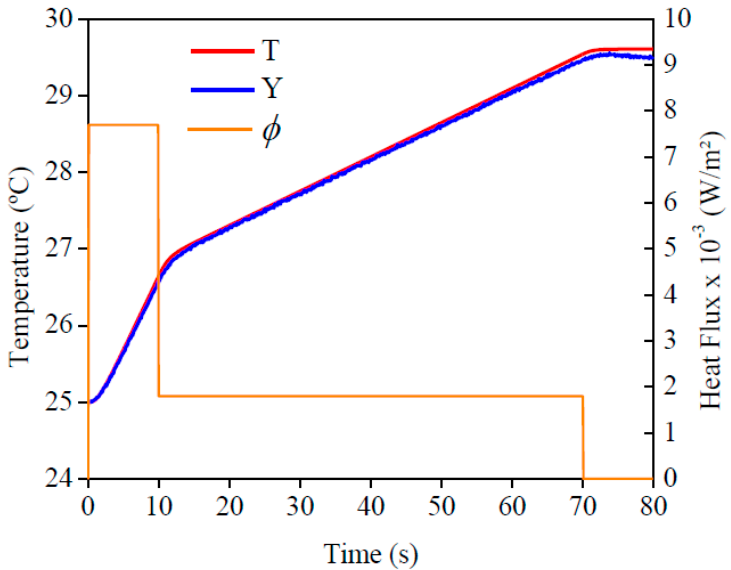
Figure 6. Experimental heat flow ( φ ) for AISI 1045. Comparison of temperatures obtained numerically ( T ) and experimentally ( Y ).